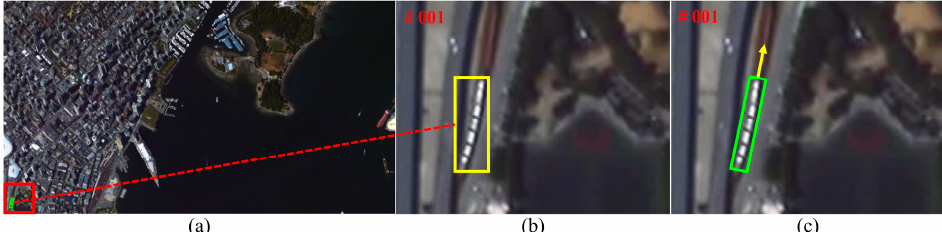
Figure 2. Visualization of different kinds of bounding boxes. The red area in the original frame ( a ) is enlarged; ( b ) shows an axis-aligned bounding box marked in yellow, whereas ( c ) shows a rotating bounding box marked in green.